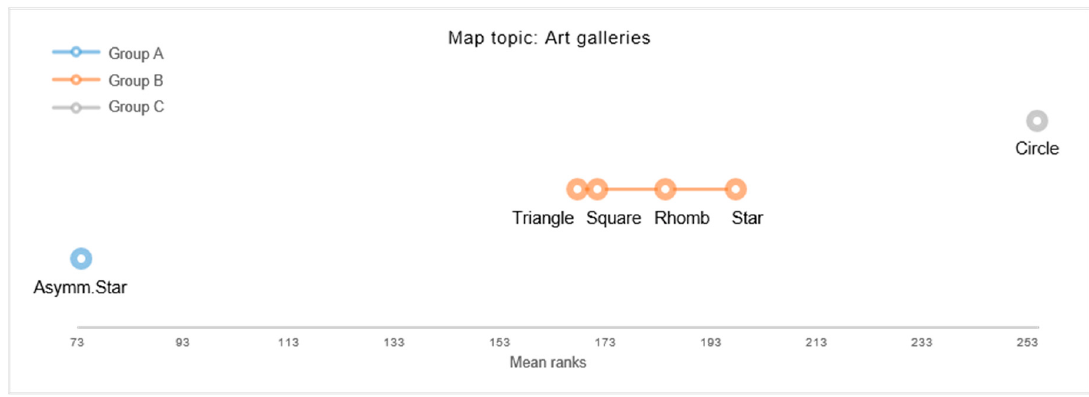
Figure 10. Map #6: Results of multiple pairwise comparisons, indicating groups of (dis)similar symbol-content congruence.